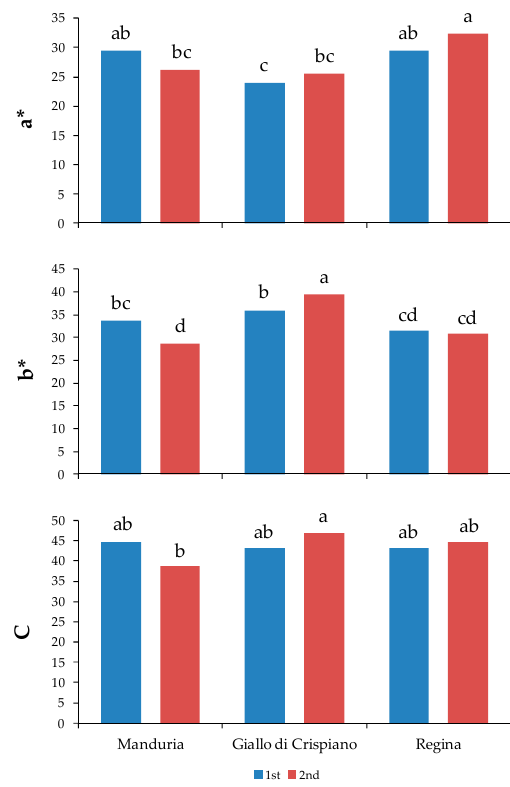
Figure 2. Color parameters ( a *, b * and C) of tomato fruits of three landraces at two harvest time: (1st) 7th, 14th and 20th July 2016, respectively for Manduria, Regina and Giallo di Crispiano; (2nd) 14th and 20th July and 4th August 2016, respectively for Manduria, Regina and Giallo di Crispiano. Interaction significance for all parameters: P ≤ 0.05. Different letters indicate significant differences at P = 0.05.